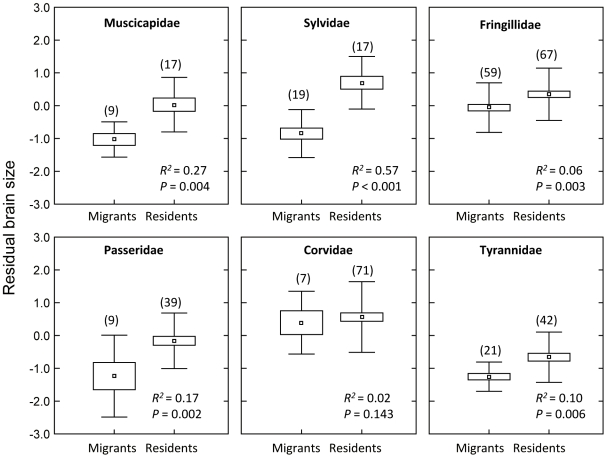
Differences in residual brain size between resident migratory species within families.The six families correspond to those for which enough species were available for the analyses. Differences are expressed as mean ± SE ± SD. Residence includes migratory distances 0 and 1 (see methods) and migration distances 2, 3 and 4. The R2 and P values come from a PGLS in which residual brain size was the response variable and migratory behavior the predictor.